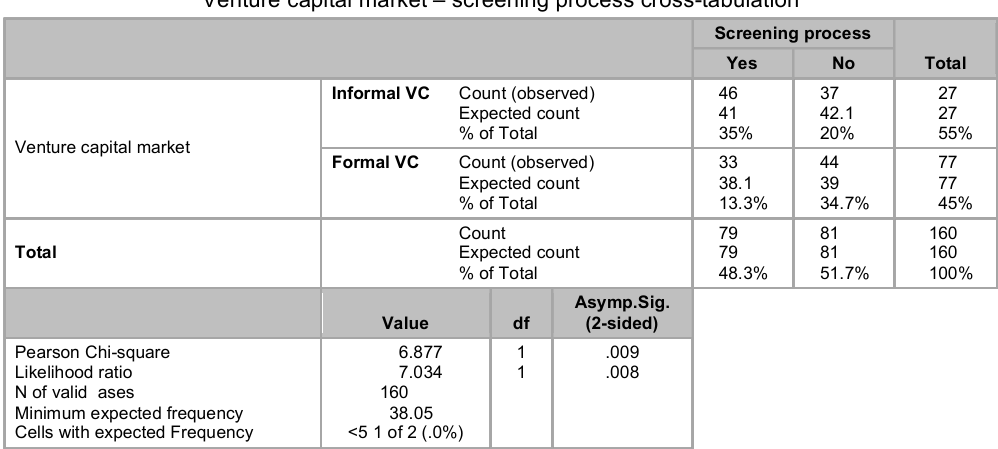
Screening process